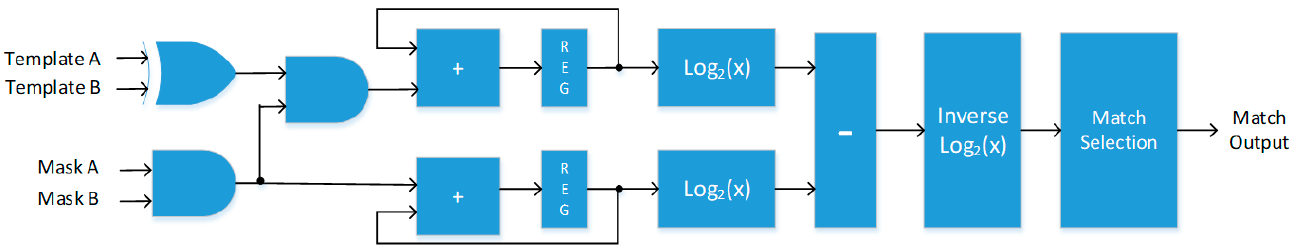
Figure 12. Block diagram of the architecture design for the template matching module.